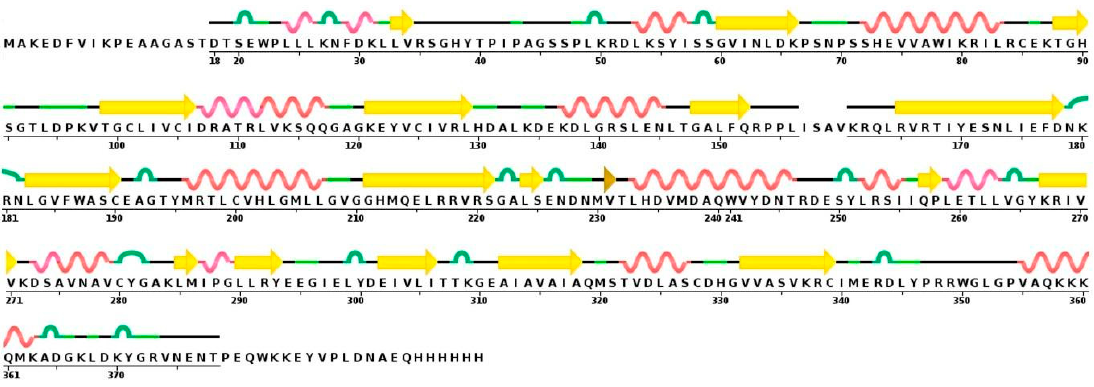
Figure 2. Secondary structure prediction of hDKC1 using HHPred (SPIDER2 (Scoring Protein Interaction Decoys using Exposed Residues) for secondary structure prediction, and DISOPRED (Disorder Prediction Server) for unstructured or disordered region predictions). Yellow arrows represent beta sheets; alpha helixes are shown in red; disordered regions are highlighted in yellow.